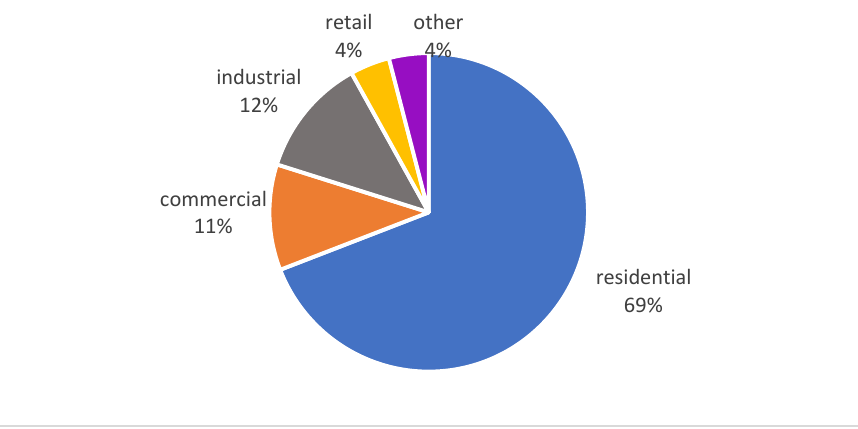
Figure 3. Distribution of coworking spaces related to the type of land use for peripheral areas.